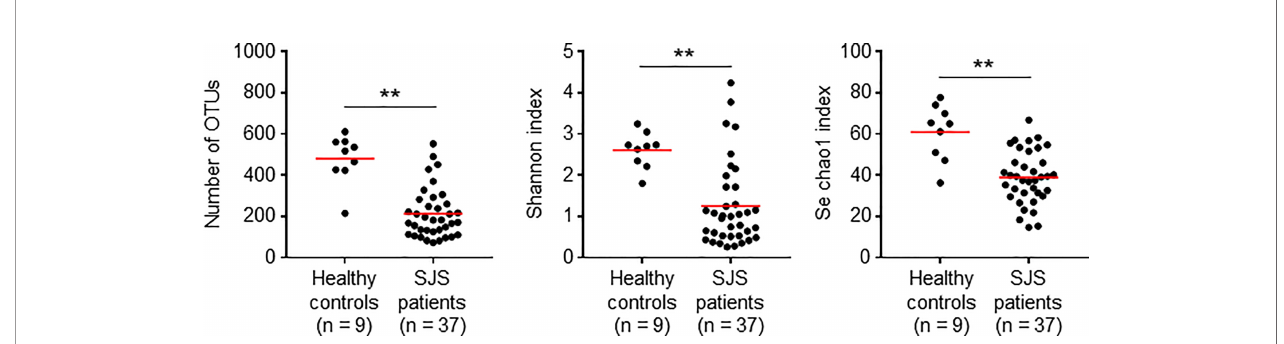
FIGURE 1 | Reduced alpha diversity in SJS/TEN patients with SOC. Statistical signi fi cance was evaluated by using the Mann – Whitney U -test; ** p < 0.01. OTU, operational taxonomic unit. SJS, SJS/TEN patients with SOC.